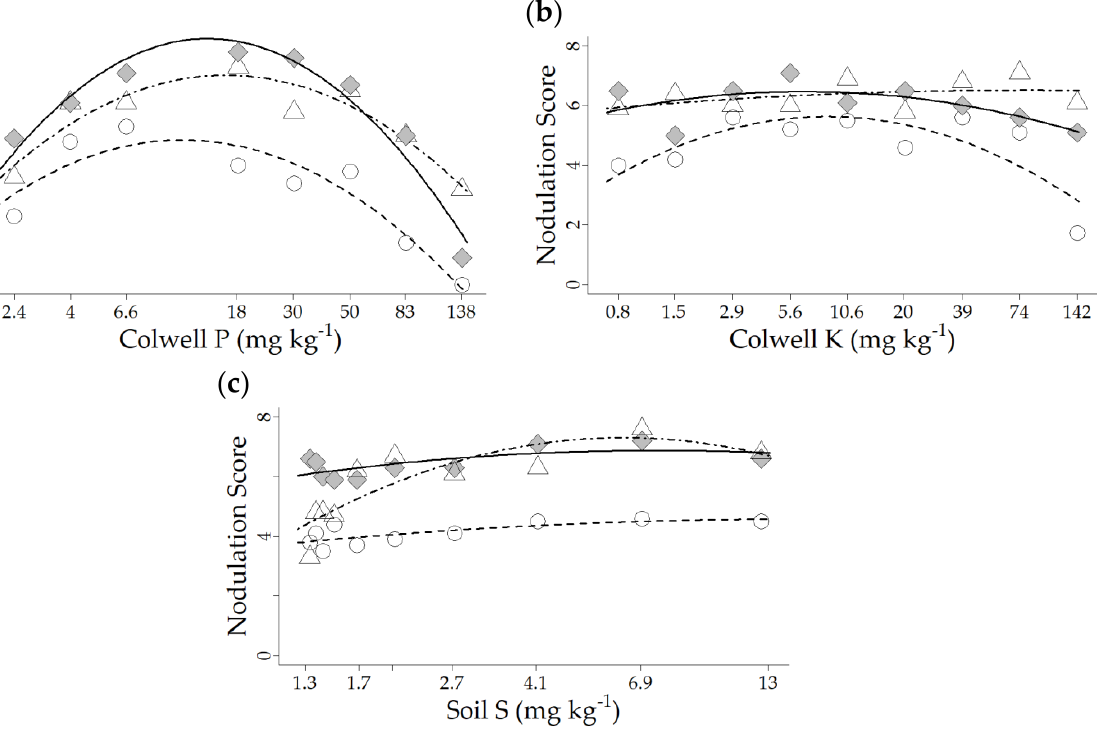
Figure 11. Nodulation scores (Yates, Abaidoo and Howieson [31]) in response to increasing levels of ( a ) Colwell P, ( b ) Colwell K or ( c ) Soil S. Circles, triangles, and diamonds represent Lanza ® , lucerne and Palma, respectively. Dashed, dotted and solid lines are fitted models for Lanza ® , lucerne and Palma, respectively. The scale on the X-axis is a log scale. Levels of Colwell P less than 4 and Colwell K less than 20 were below the detectable limits of the soil tests and have been estimated from smoothed models of soil test results vs. added nutrients.